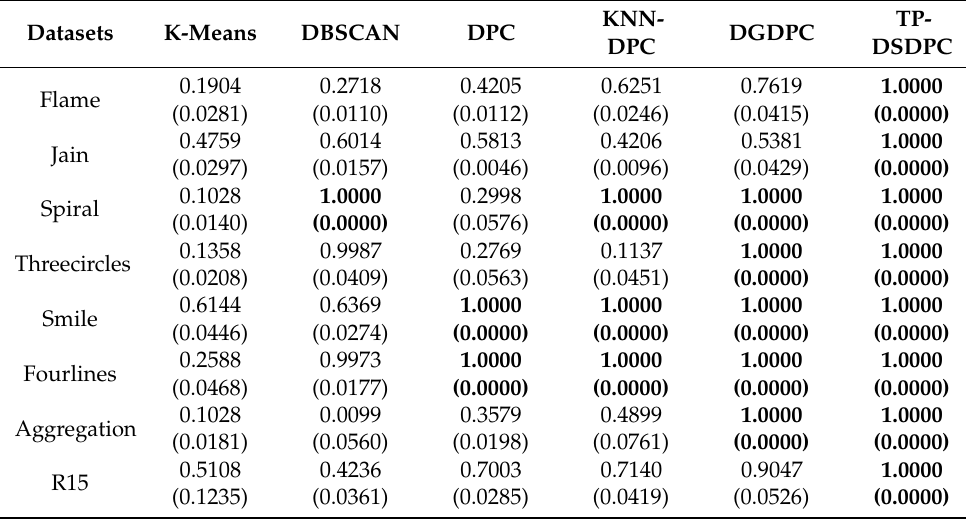
Table 6. The ARI of the six algorithms on nine synthetic datasets.